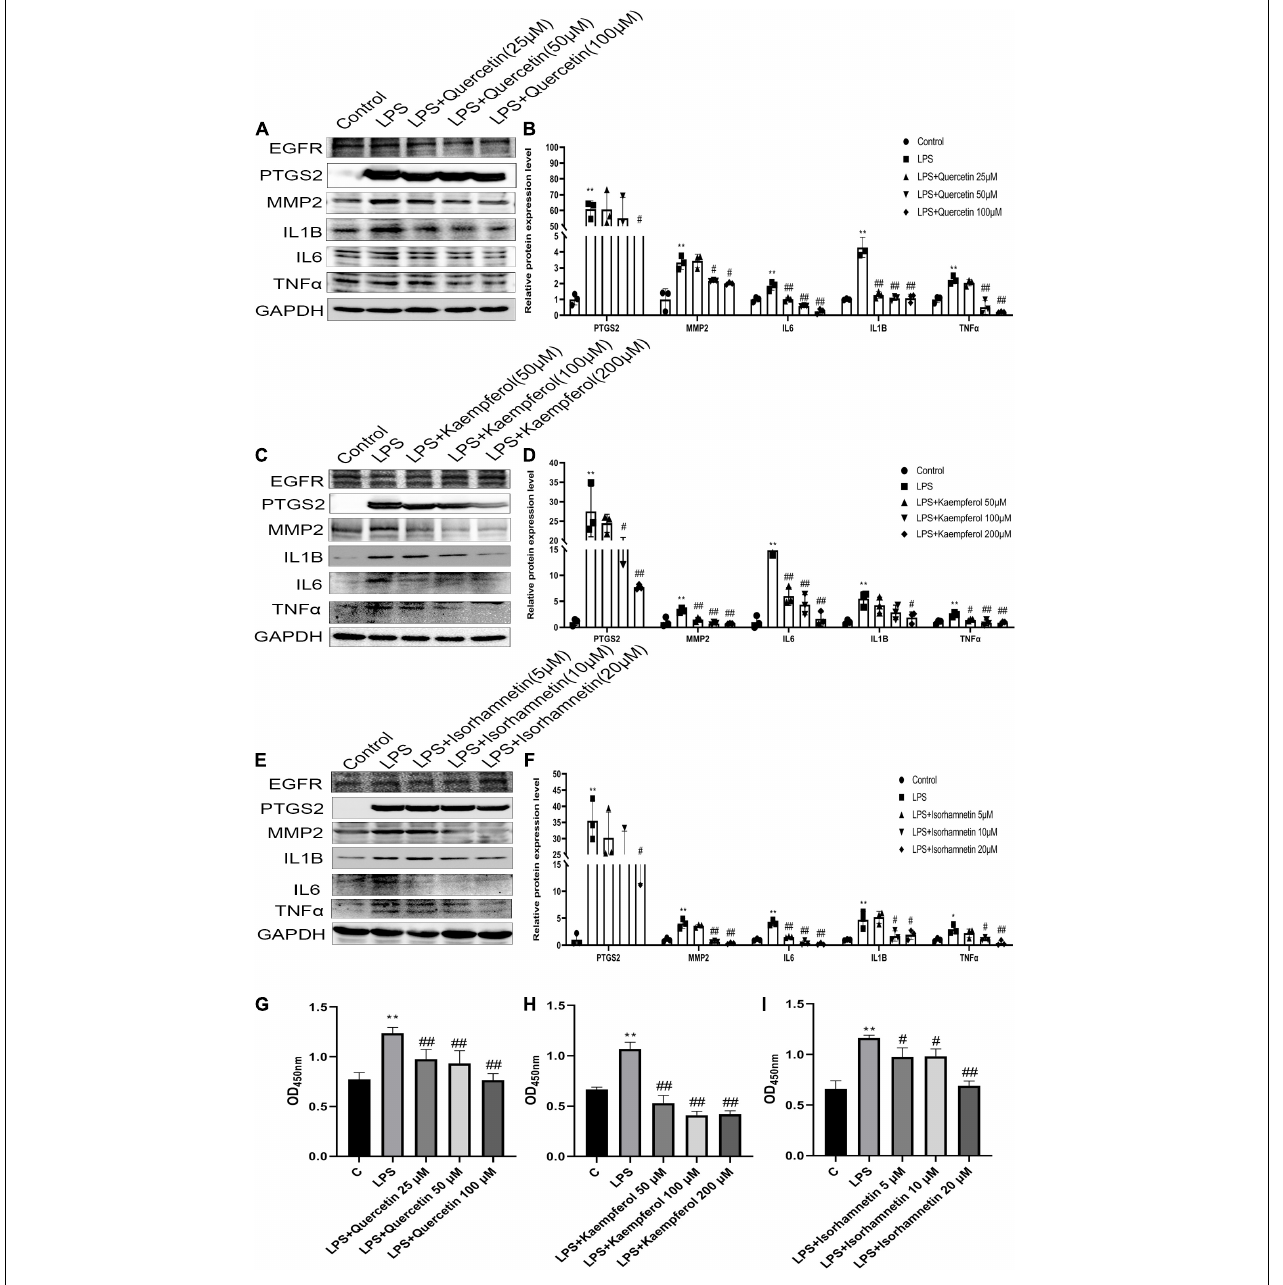
FIGURE 7 | The effective compounds (quercetin, kaempferol, isorhamnetin) attenuate LPS-induced the elevation of PTGS2, MMP2 and pro- inflammation cytokines (IL1B, IL6, TNF α ) of RAW264.7 cells. The protein expression of PTGS2, MMP2 and pro- inflammation cytokines (IL1B, IL6, TNF α ) of RAW264.7 cells treated with quercetin (A,B) , kaempferol (C,D) , isorhamnetin (E,F) .The viability of RAW264.7 cells treated with quercetin (G) , kaempferol (H) , isorhamnetin (I) . * P < 0.05 vs. Control; ** P < 0.01 vs. Control; # P < 0.05 vs. LPS; ## P < 0.01 vs.